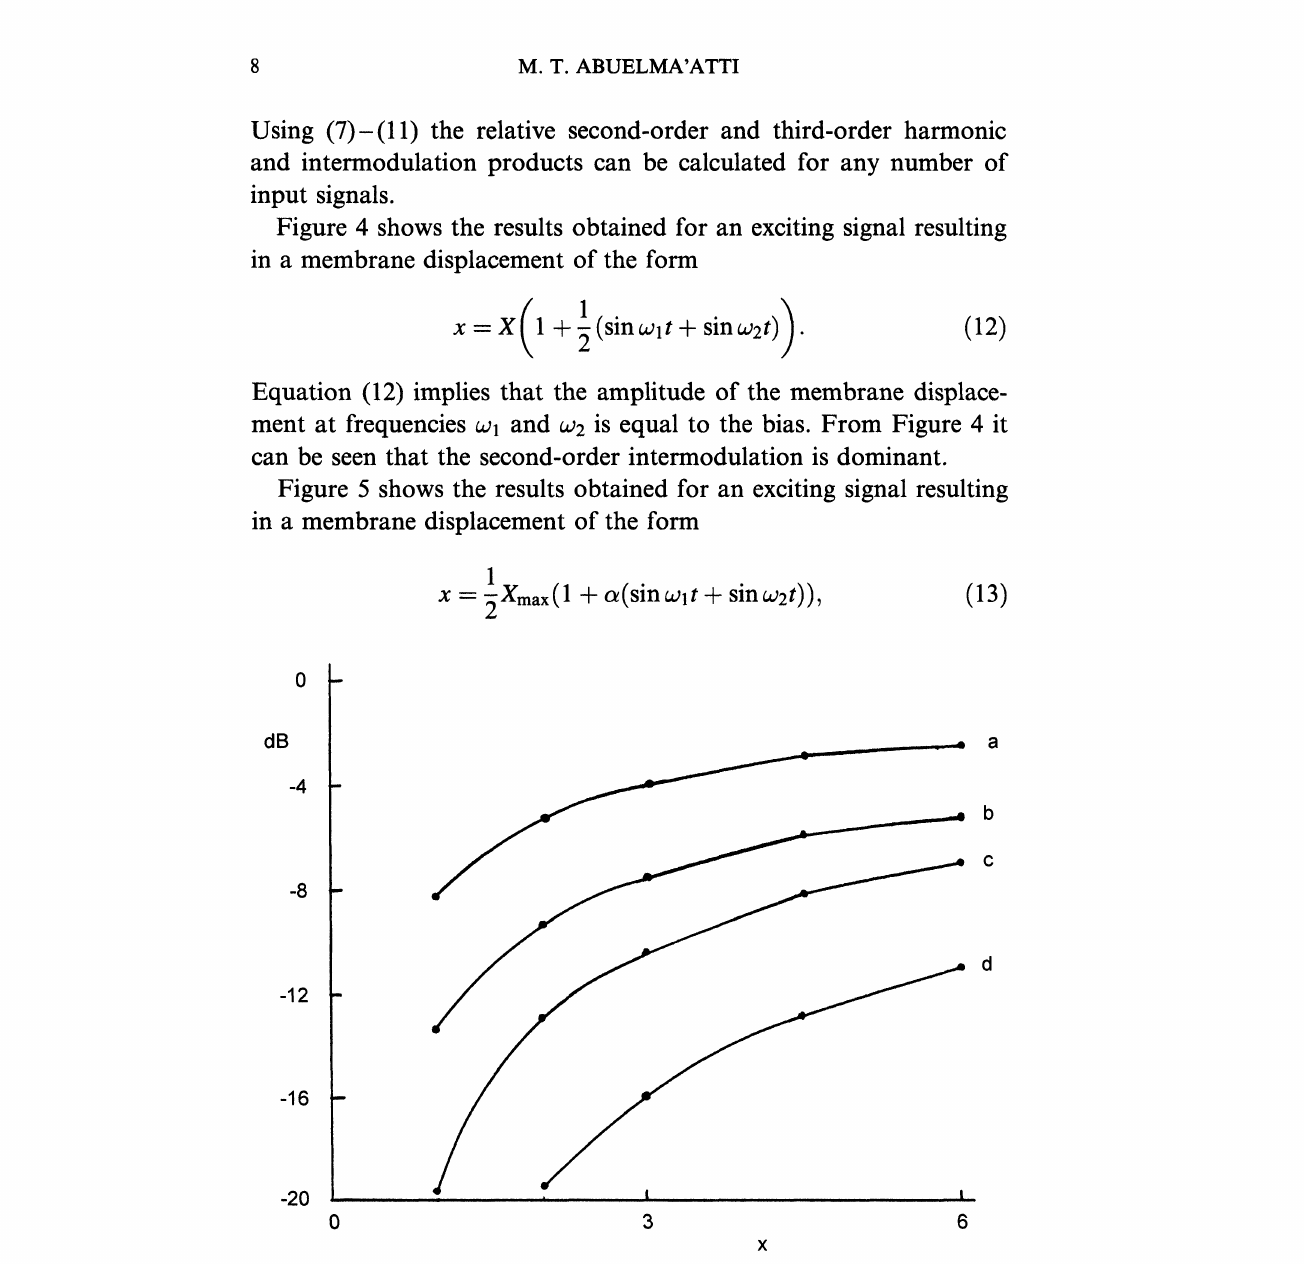
FIGURE 4 Variation of the harmonic and intermodulation products as a function of X with a membrane-displacement of the form of Eq. (12). a: intermodulation product wl + w2, b: second-harmonic product 2wl (or: 2w2), c: intermodulation product 2w 4-WE (or: 2w2 4- w), d: third-harmonic product 3w (or: